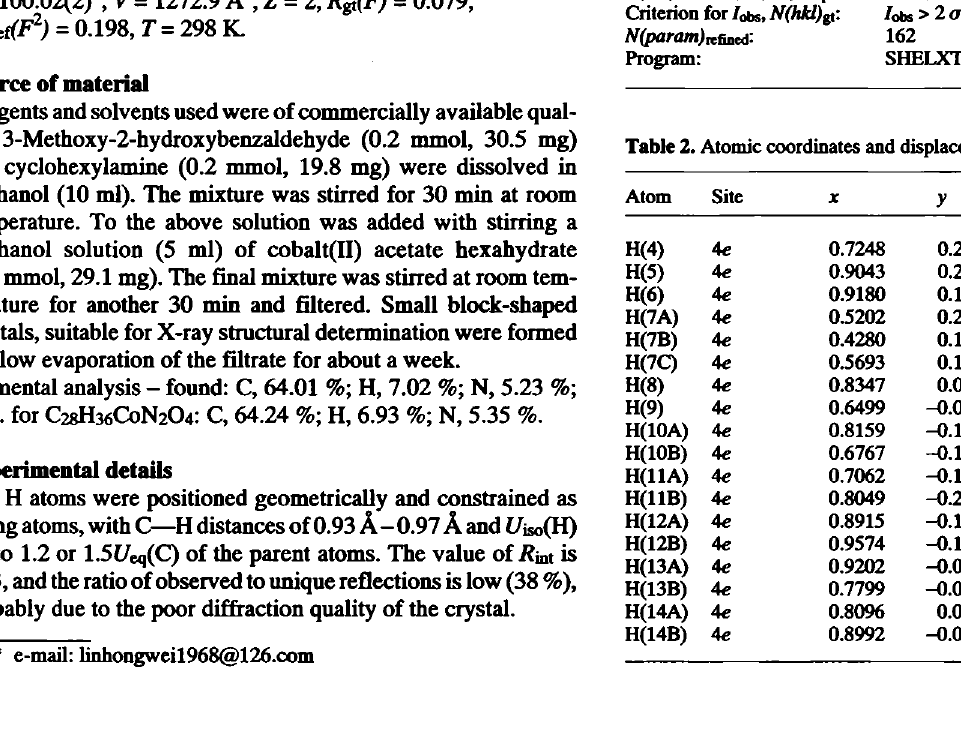
Table 1. Data collection and handling.